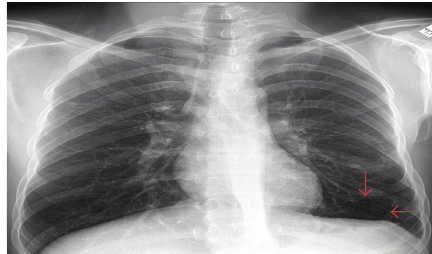
Figure 2: CXR: left lung cyst (red arrows).